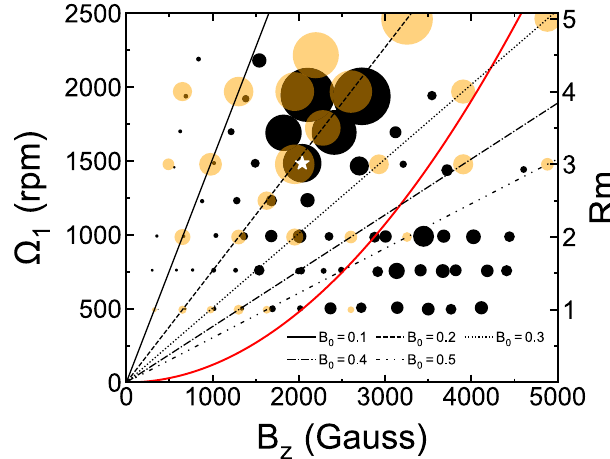
Fig.3|Shearandmagnetic fi elddependenceoftheinstability. Bubbleplotofthe instability strength from experiments (black bubbles) and 3D simulations (orange bubbles)inthe Ω 1 - B z planewithRmshownontheright.Thedataareobtainedinthe midplane and at the innercylinder surface. The red curve representsthe boundary for SSL instability. The straight lines show the contoursof a constant B 0 . The black bubble under the white star corresponds to the case shown in Fig.